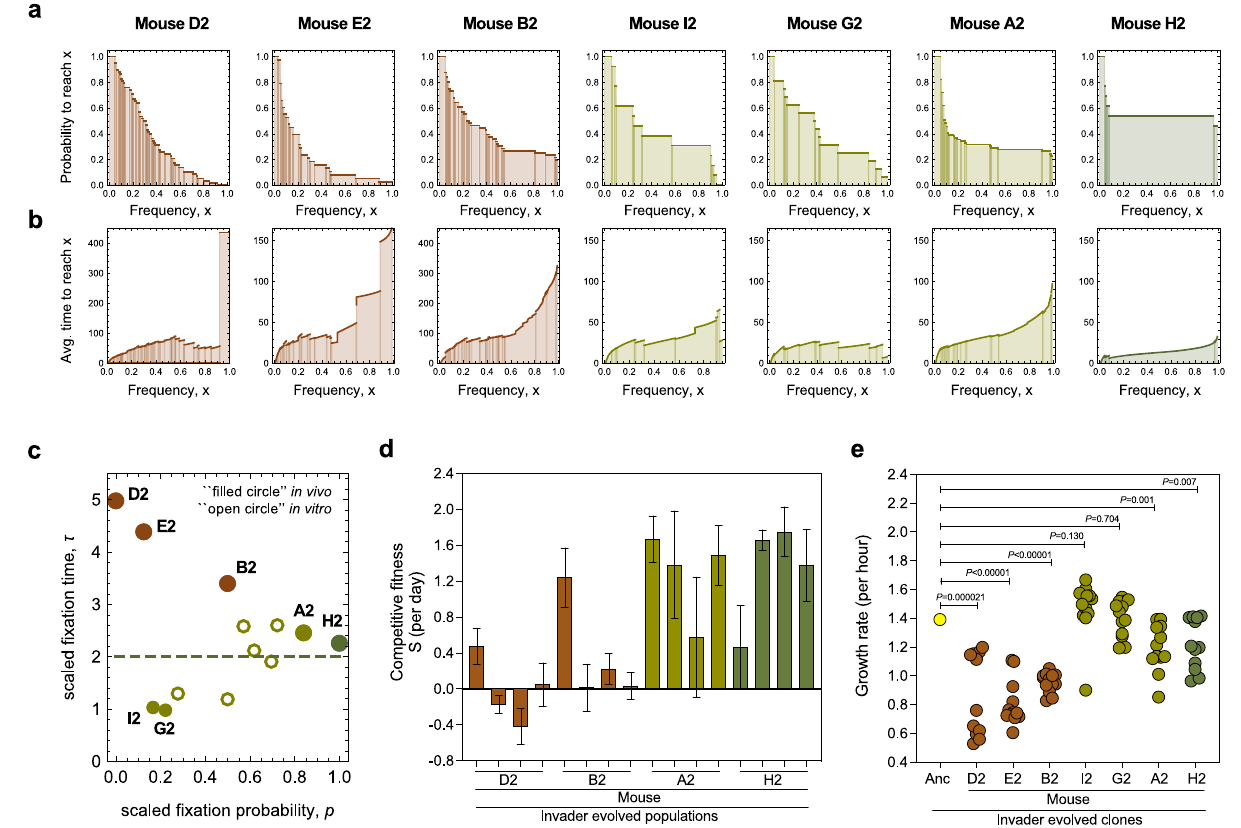
Fig.4|Modesofevolutionand fi tnesstradeoffs.a – c A p - τ selectiontestcaptures the joint statistics of fi xation probabilities a , and times b . This test c, identi fi es dominant diversifying selection in mice D2, B2, and E2 (brown), and directional selection generating clonal interference in mice A2, G2, and I2 (green) or periodic sweeps in mouse H2 (dark green). In mouse D2, where no fi xations occur, we use the time to the end of the experiment lower bound for τ . The reference value τ ≈ 2 expected for directional selection in the low-mutation regime is shown as dashed line.Short-termtrajectories(<2000generations)aremarkedbysmallsymbols.The data from Lenski ’ s in vitroevolution experiment 1 , forthe samelinesasinFig.1, are shown as open circles. d Host speci fi city of in vivo adaptation. Relative fi tness of pools of evolved clones from mice D2, B2, A2 and H2 when competing against the